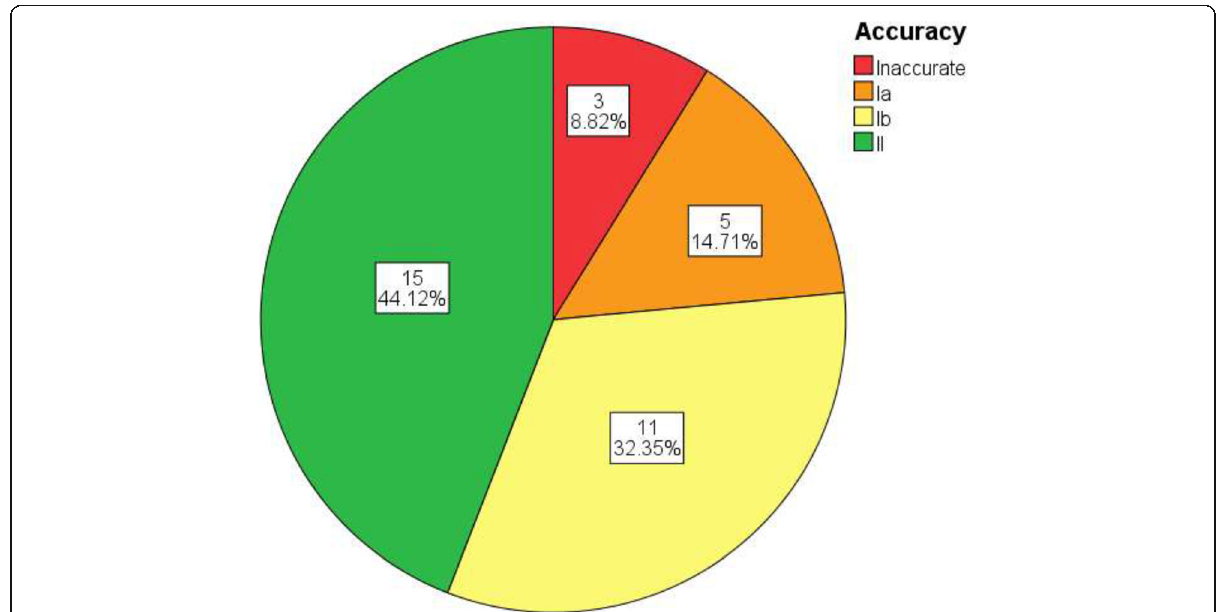
Fig. 11 Pie chart showing the accuracy of US-guided fluoroscopic-verified dorsal root ganglia pulsed radiofrequency cannula